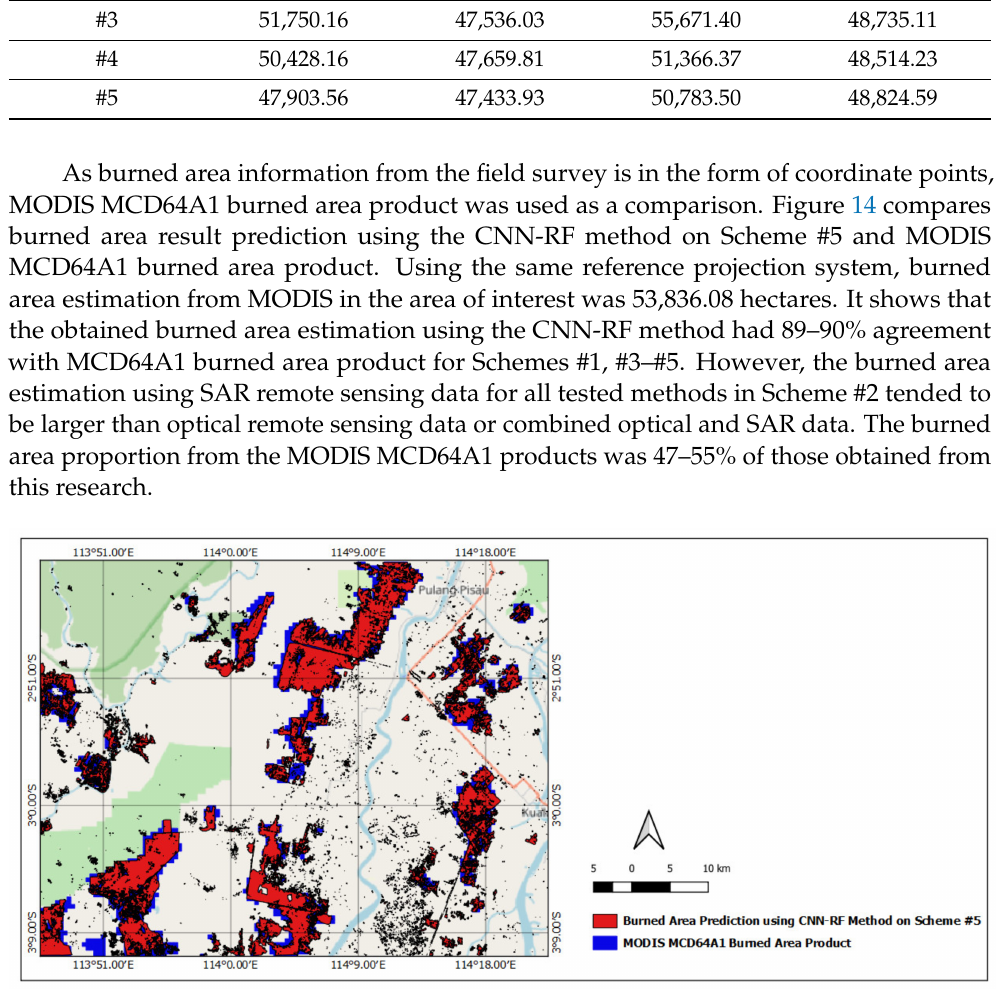
Figure 14. Comparison of burned area prediction using the CNN-RF method on Scheme #5 and MODIS MCD64A1 burned area product in the study area in